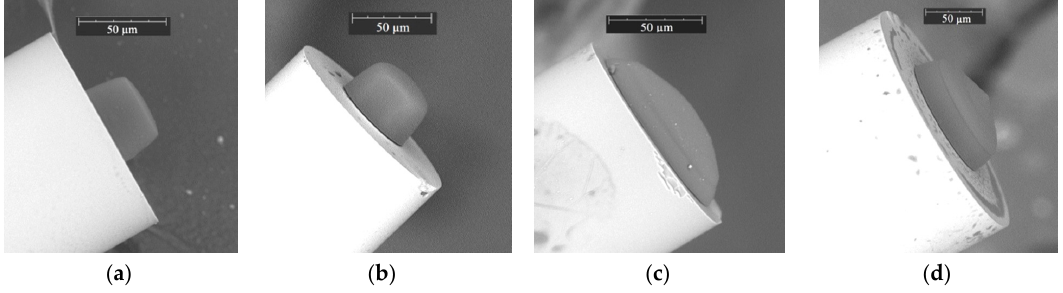
Figure 4. The SEM images of microtips obtained using UV LED with acetophenone PIS on MMF with a respective RI profile, core diameter, optical power, exposure time, and monomer type: ( a ) step-index, 50 µm, P = 5 µW, t = 30 s, PETA; ( b ) gradient-index, 62.5 µm, P = 20 µW, t = 10 s, PETA; ( c ) step-index, 105 µm, P = 30 µW, t = 30 s, PETA; ( d ) step-index, 200 µm, P = 5 µW, t = 60 s, tricyclo